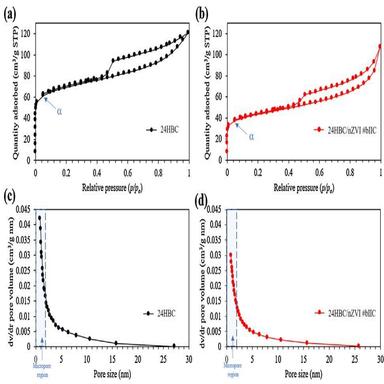
Nitrogen adsorption/desorption isotherms for (a) 24HBC, and (b) 24HBC/nZVI #bIIC. Pore size distribution graphs for (c) 24HBC, and (d) 24HBC/nZVI #bIIC.